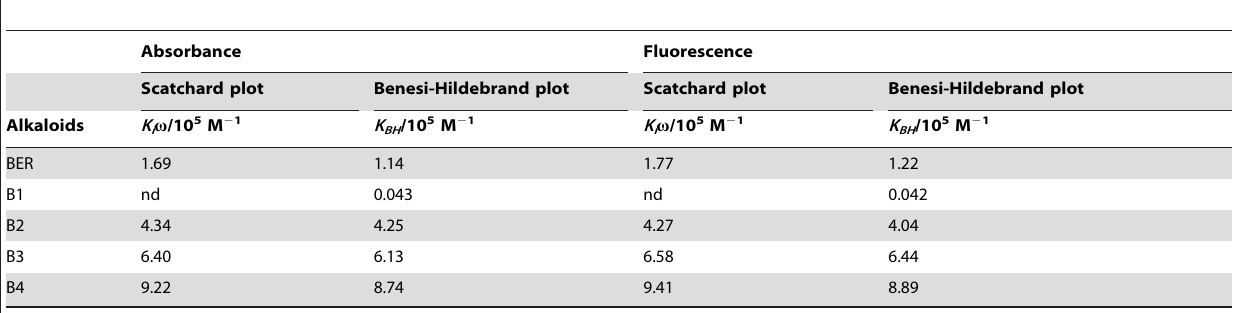
Table 1. Binding parameters of complexation of BER and its analogs with tRNA from spectrophotometric and spectrofluorimetric studies a